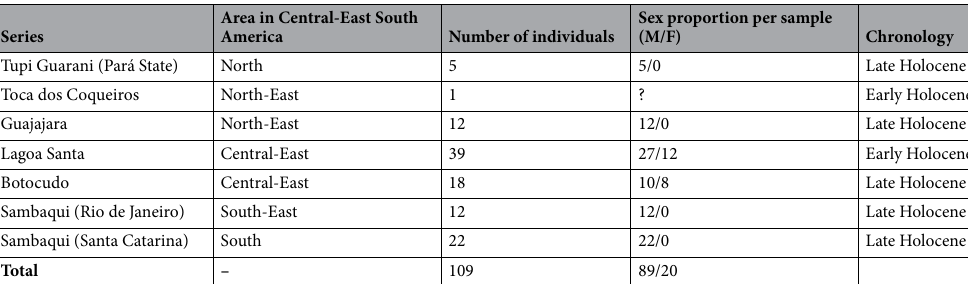
Table 1. Comparative samples from Central-East South America used for the morphometric analysis.